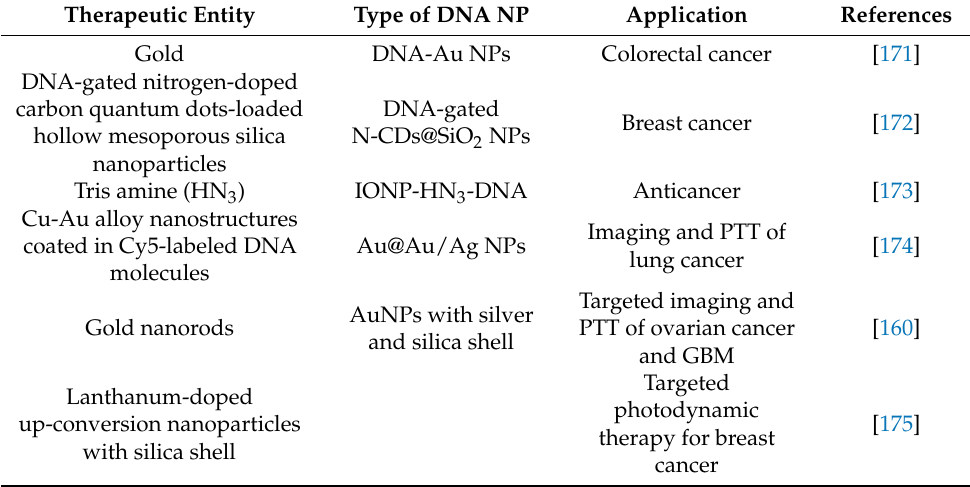
Table 11. Types of DNA-based nanoparticles with their applications in cancer